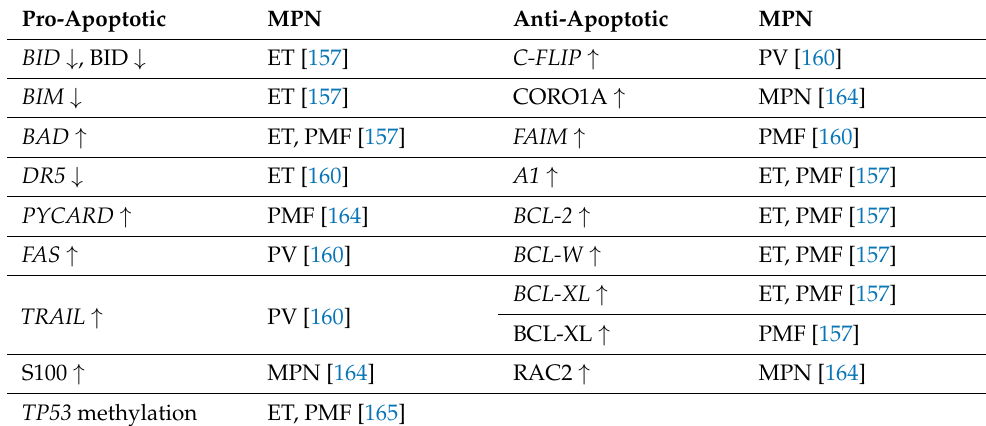
Table 2. Expression of apoptosis-related factors in granulocytes of MPN